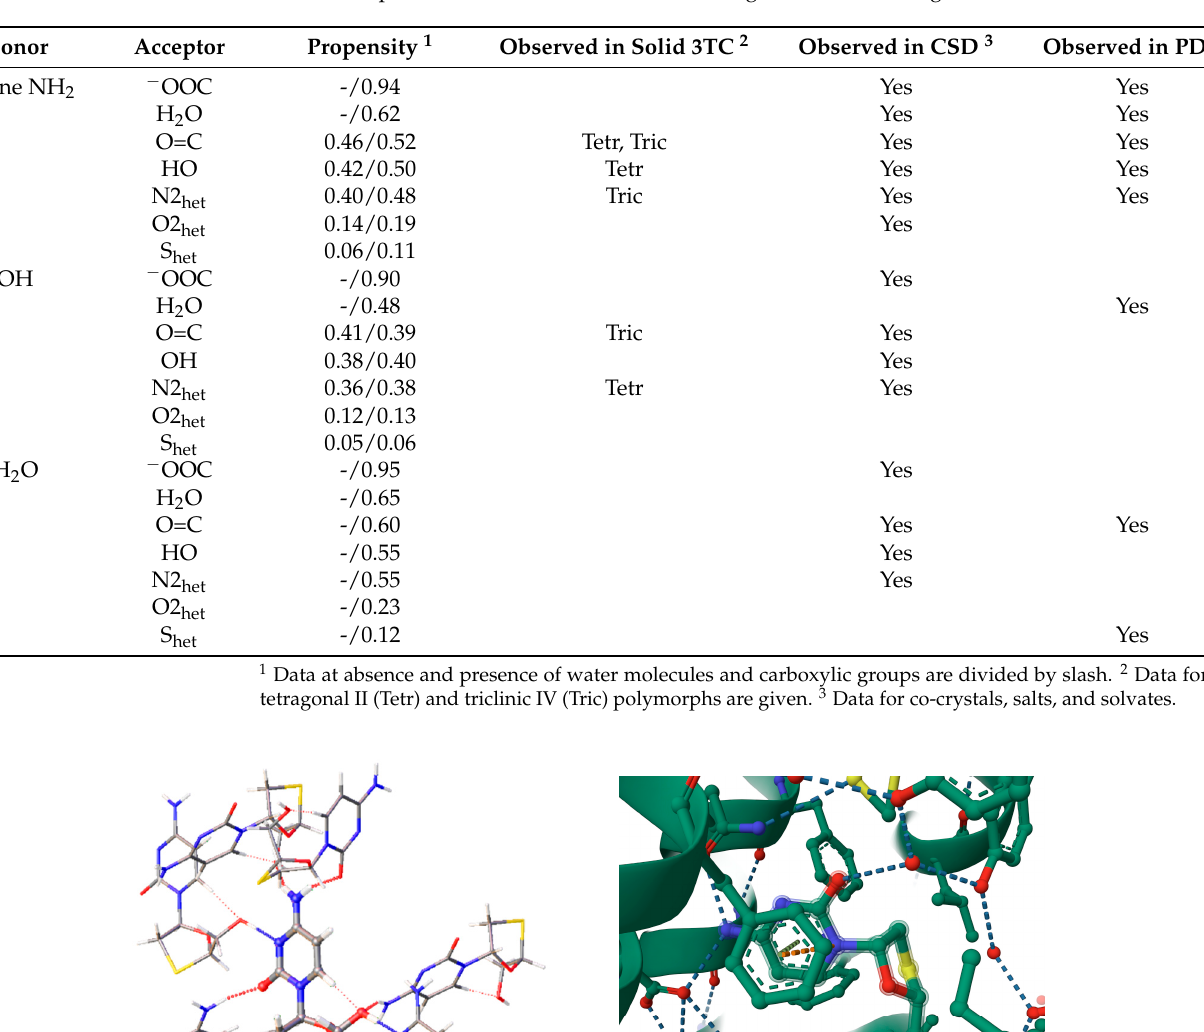
Table 2. Propensities of intermolecular H-bonding in 3TC-containing solids.